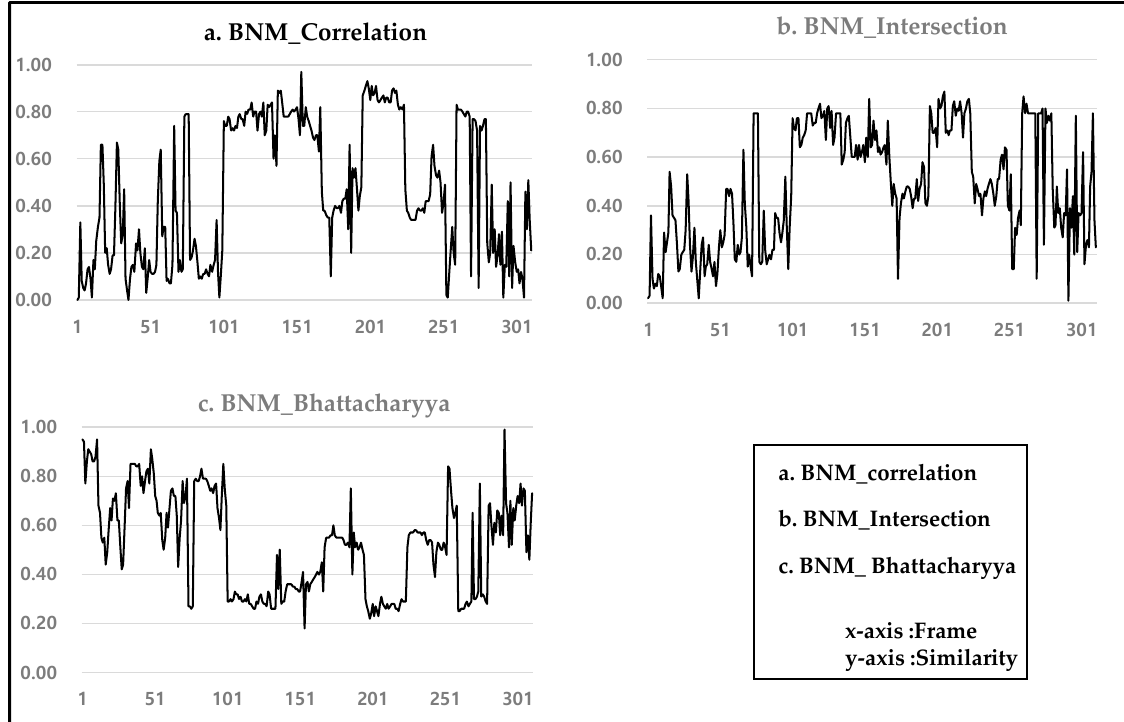
Figure 6. Threshold for each algorithm. Table 5. Threshold of algorithms according to brightness, perspective, and shooting angle.